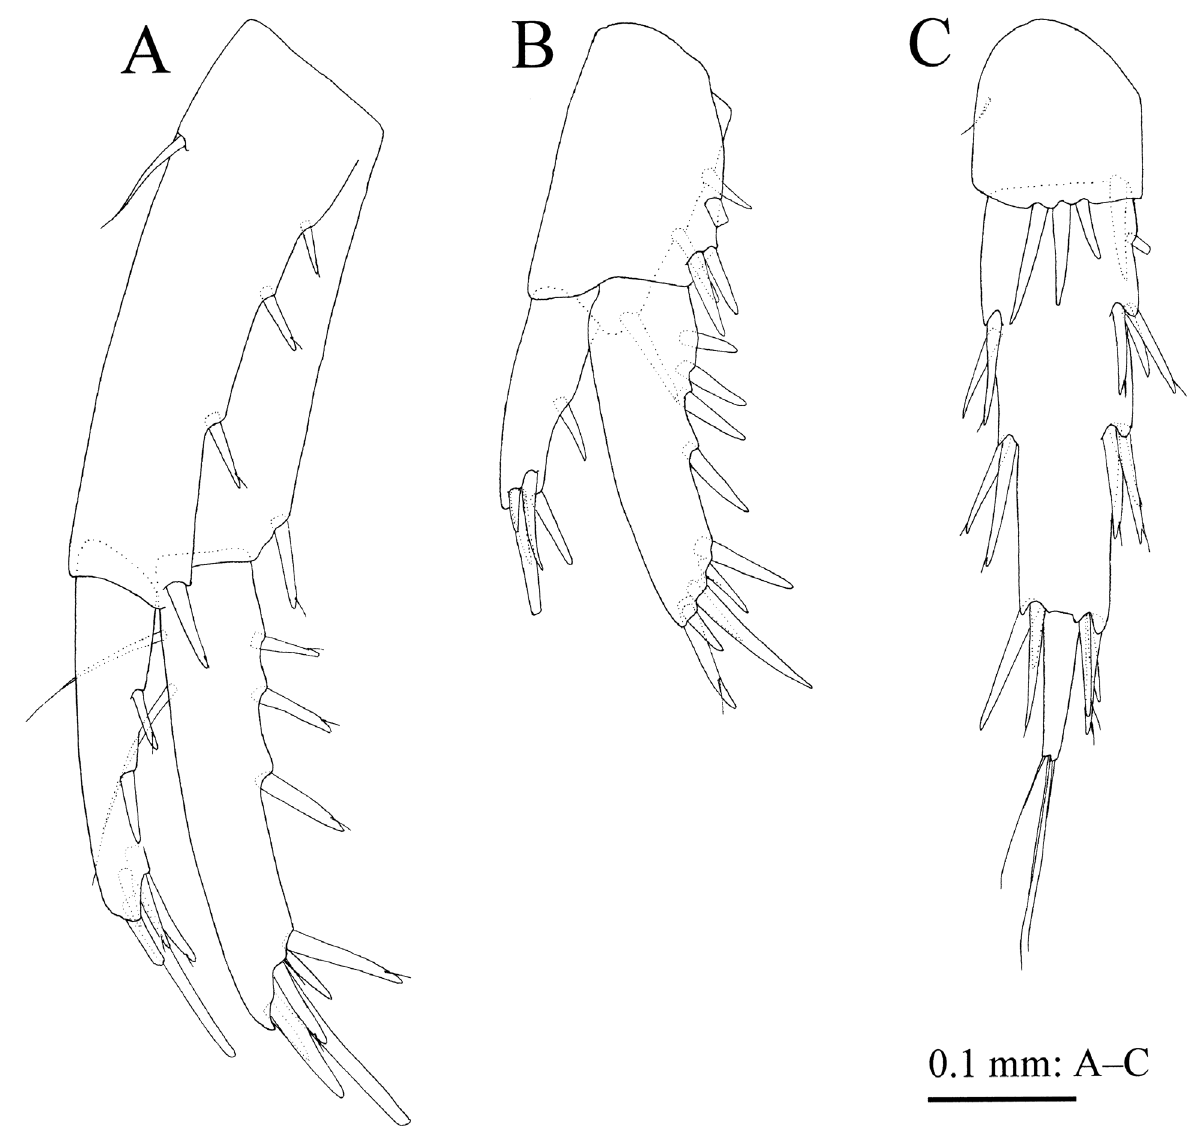
Figure 9. Pseudocrangonyx gudariensis Tomikawa & Sato, sp. n., paratype, female (3.1 mm), NSMT-Cr 24604. A–C uropods 1–3, respectively, dorsal